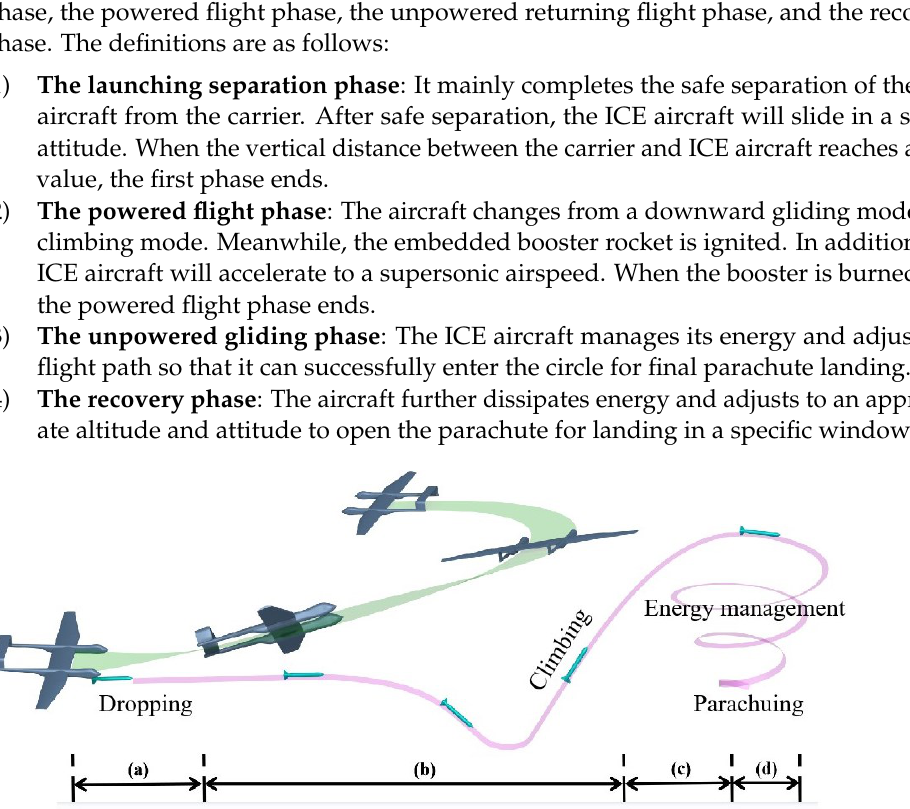
Figure 1. The mission is divided into four phases: (a) the launching separation phase; (b) the powered flight phase; (c) the gliding phase; (d) the recovery